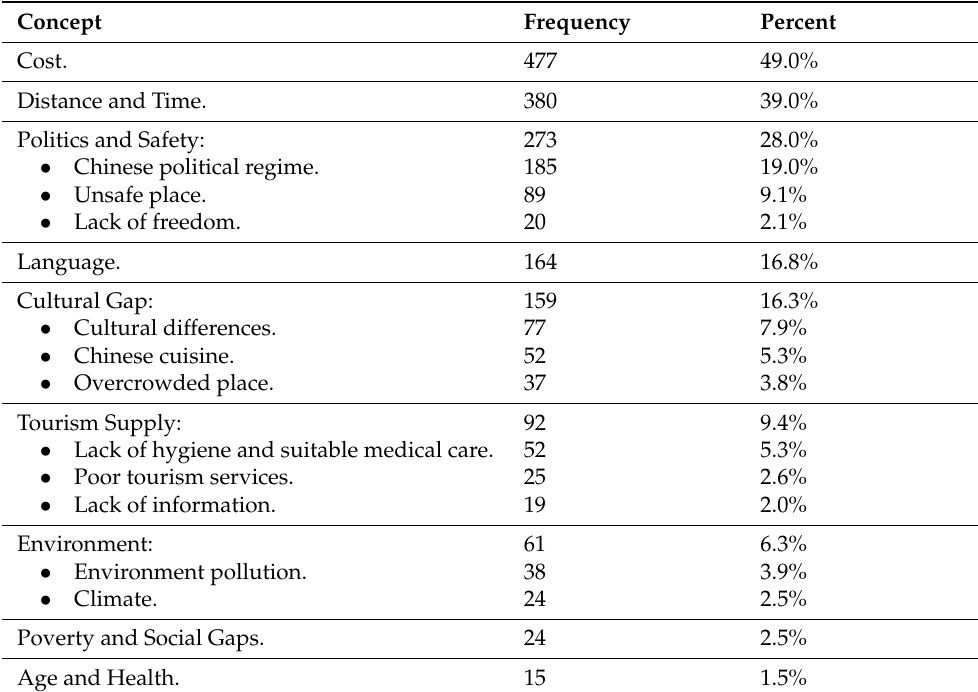
Table 9. Factors inhibiting visits to China (open-ended